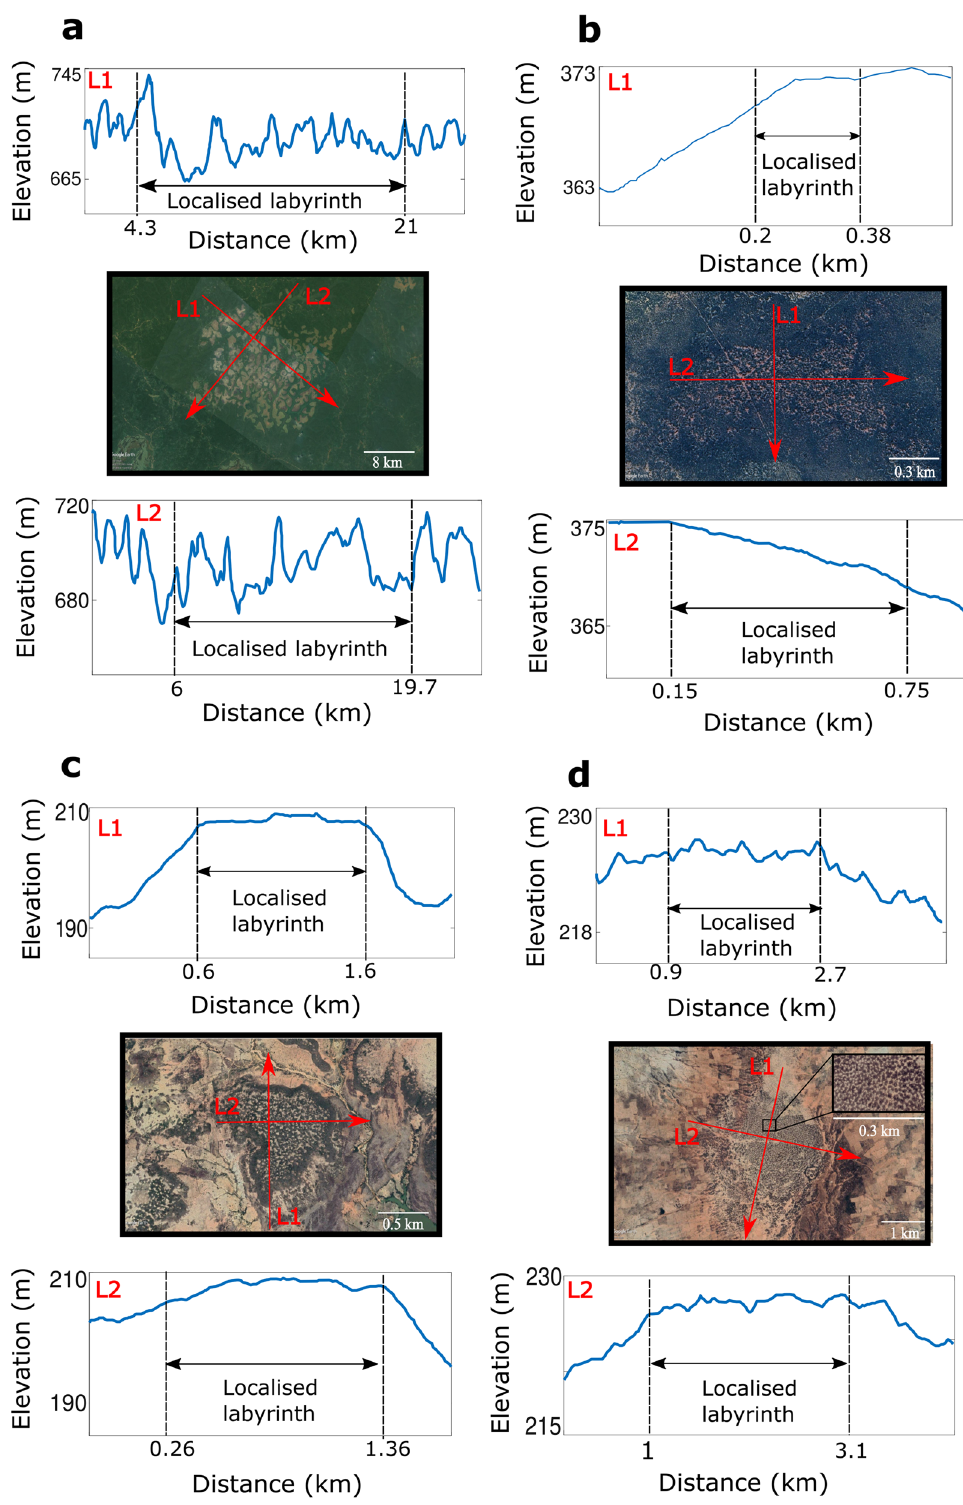
Figure 2. Elevation profiles of the localised labyrinths observed in nature (Fig. 1). They were obtained using Google Earth software (https:// earth. google. com/ web/). In each zone two elevation profiles are shown for two arbirtary cross-sections (L1 and L2). ( a ) The localised labyrinth in central Cameroon has large fluctuations in height ranging from 665 to 745 m. The homogenous cover that surrounds the localised labyrinth also has fluctuations in height of the same order. The size of the major axis of the localised pattern is 16.7 km. ( b ) In Western Australia the localised labyrinth is in a gentle slope ( 0.8% ), the size of its major axis is 0.6 km. ( c ) and ( d ) shows the elevation profiles of the localised labyrinths in Southwest Niger. Both patterns are in small hills of about 10 m, surrounded by a bare state. These localised labyrinths emerge in plain terrains. The sizes of the major axes are 1.0 km and 2.0 km, respectively. See the "Methods" section for details on the accuracy of the elevation